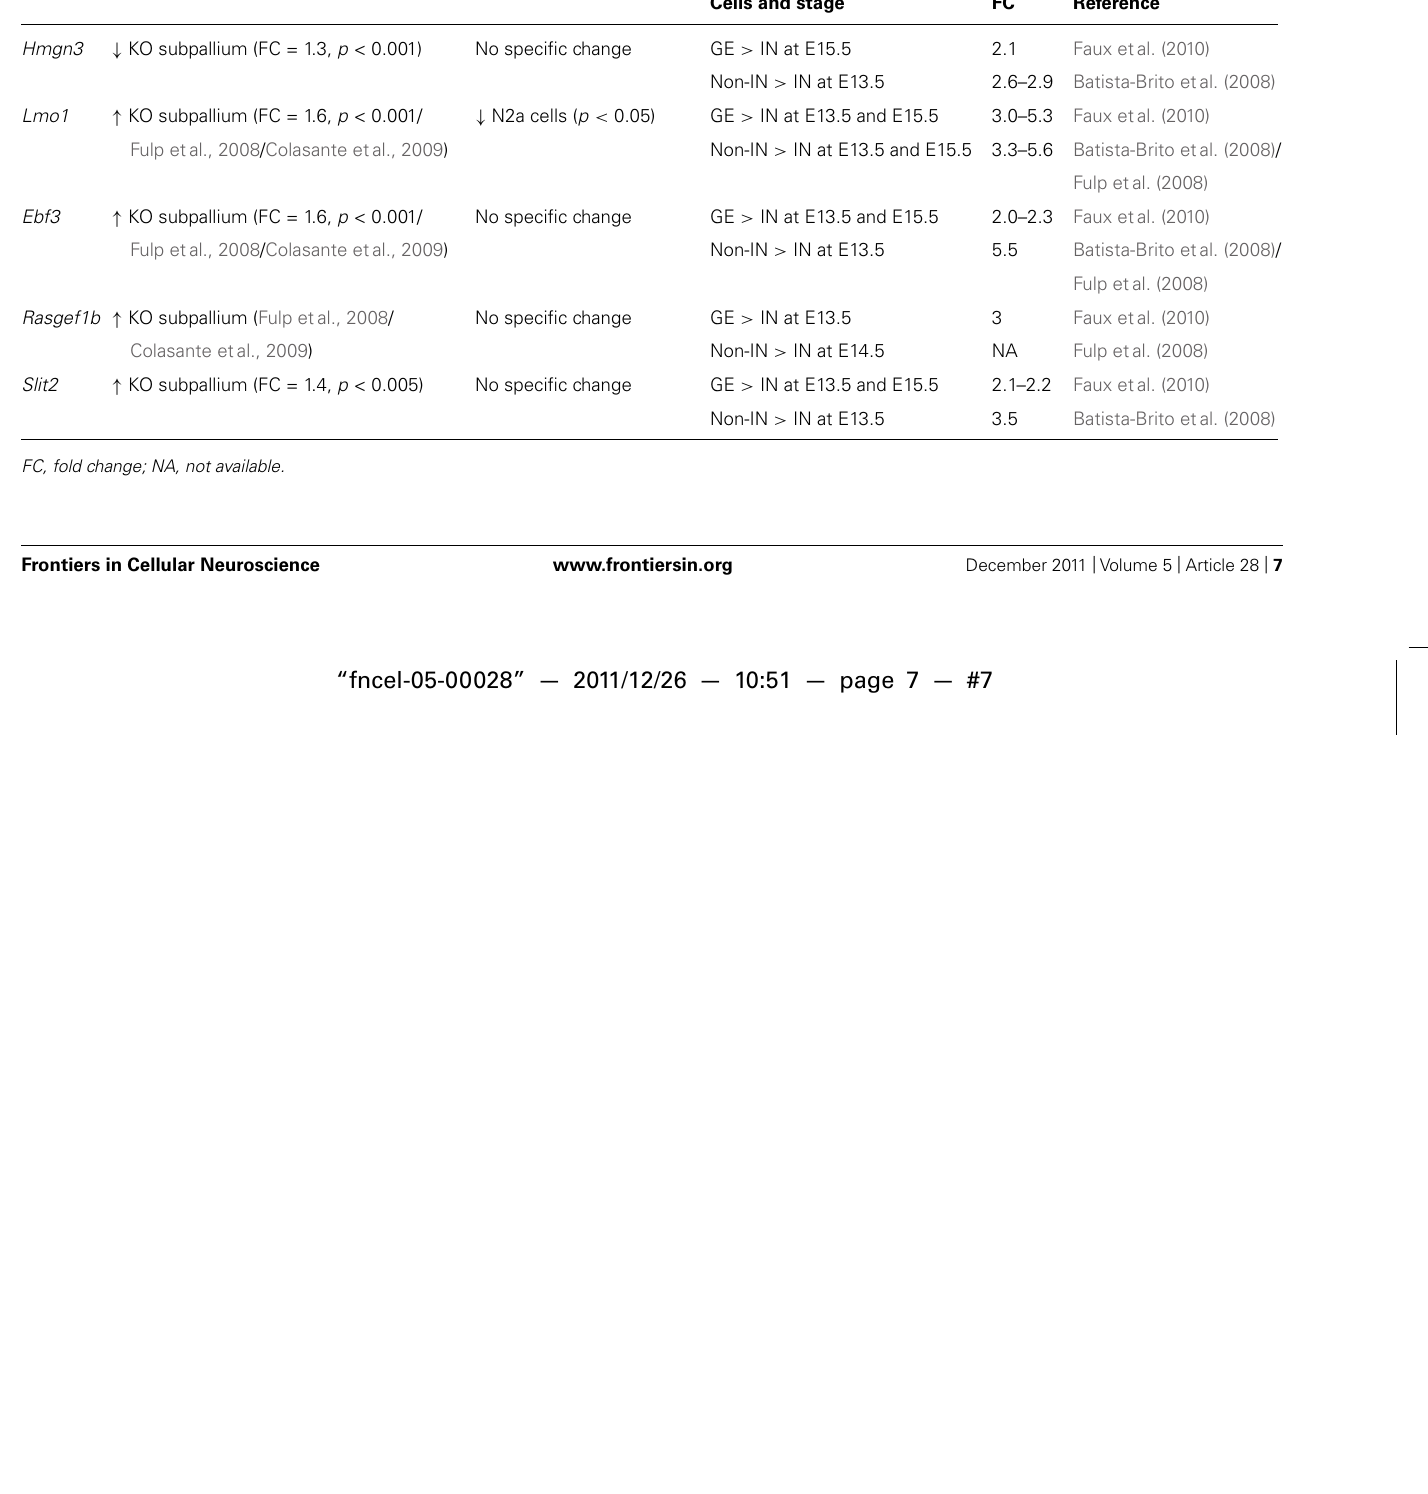
Arx-transfected N2a cells Expression in cortical migrating interneurons (Quillé etal., 2011) Cells and stage FC Reference GE > IN at